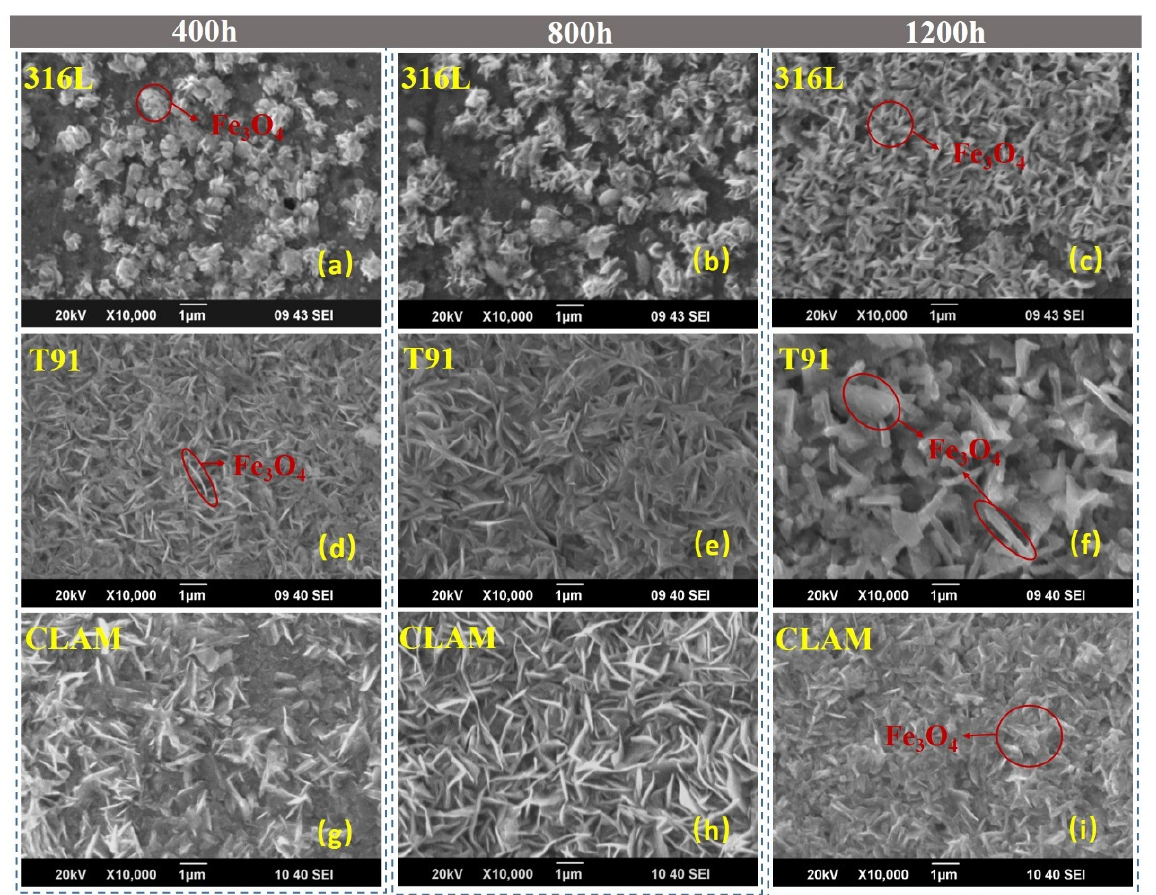
Figure 8. Surface morphology of the corroded samples: ( a ) 316L-400h, ( b ) 316L-800h, ( c ) 316L-1200h, ( d ) T91-400h, ( e ) T91-800h, ( f ) T91-1200h, ( g ) CLAM-400h, ( h ) CLAM-800h, ( i ) CLAM-1200h.